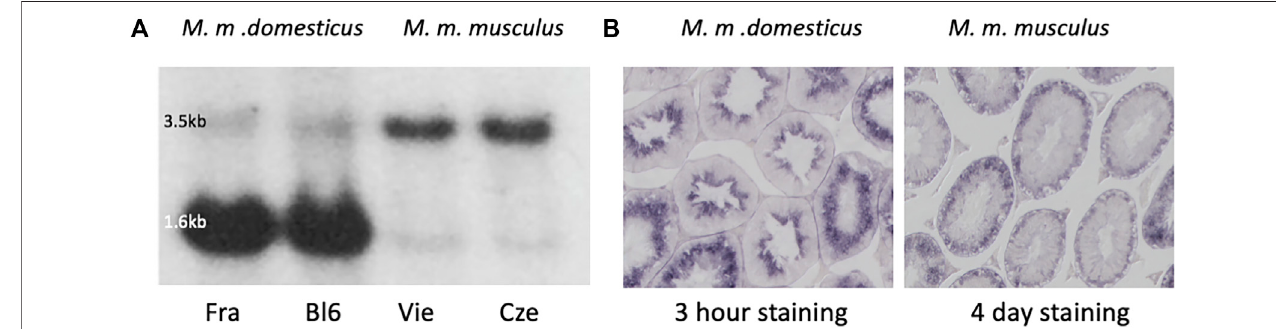
FIGURE 1 | Map2k7 expression in M. m. domesticus versus M. m. musculus . (A) Northern blots with testis RNA from M. m. domesticus individuals of a wild populationfromFrance (Fra) andthelaboratoryinbredstrain C57Bl6/J (Bl6),aswellas M. m.musculus individualsfromawild-caught populationfromVienna(Vie) anda wild-caught population from the Czech Republic (Cze). A fragment spanning exons 5-10 was used as a probe (see Methods for generating this fragment). The strongly expressed 1.6 kb band is only visible in the two individuals from the M. m. domesticus subspecies. The weak 1.6 kb band in M. m. musculus is derived from anothertranscriptvariantthatdifferswithrespecttoanadditionalintron inthe3 ′ -endofthelongtranscript (compare annotationin Figure2 ). (B) Insitu hybridization with the Map2k7 probe on cross-sections of seminiferous tubules of an individual from M. m. domesticus (left) and an individual from M. m. musculus (right) was the same fragment as used for the Northern blots. Note that the M. m. domesticus signal developed already after 3 h of color incubation, while the M. m. musculus signal developedonlyafter4 daysofcolorincubation.Thisiscompatiblewiththefactthatthesignalin M.m.domesticus comesmainlyfromthestrong1.6 kbtranscriptseenin the Northern blot, while the signal in M. m. musculus comes from the weaker 3.5 kb transcript. Microscope pictures were taken at × 100 magni fi cation.